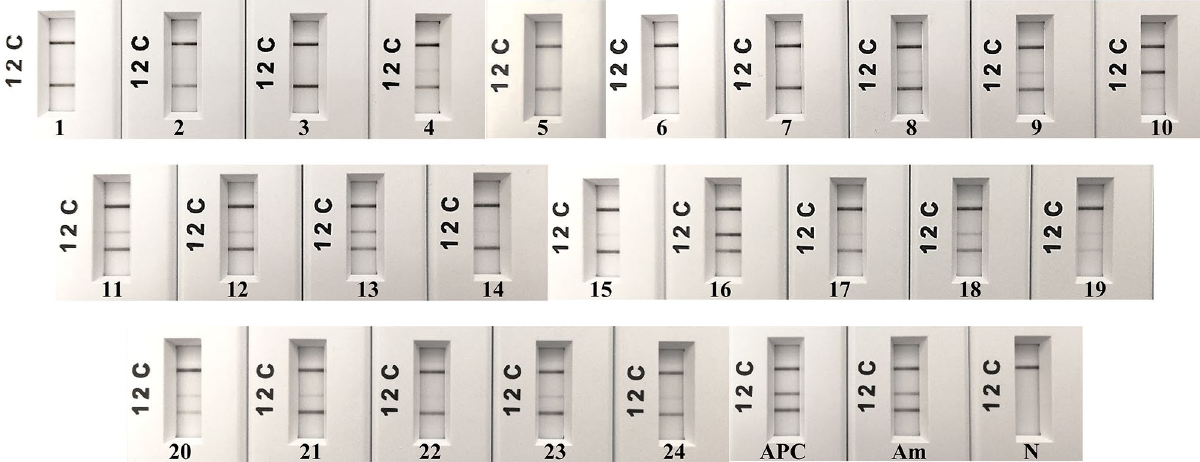
Figure 5. A. marginale multiplex RPA- nfo using positive serum samples. Lane C, flow-check line; Lane 2, detects FAM/Biotin labelled amplicons ( A. marginale) ; Lane 1, detects DIG/Biotin labelled amplicons (GAPDH gene); 1–24, A. marginale positive serum samples; APC, Artificial positive control; Am, A. marginale positive reference control; NTC, non-template control